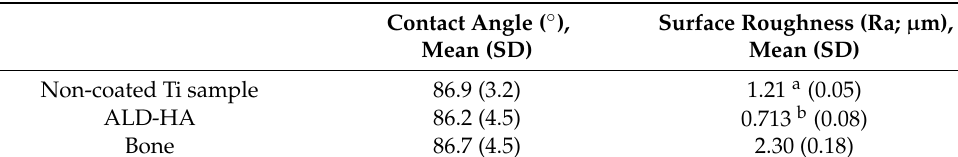
Table 1. Mean and standard deviation of water contact angle and surface roughness determination on non-coated Ti sample, ALD-HA, and bovine bone slice. a p < 0.001, non-coated Ti sample vs. ALD-HA or bone; b p < 0.001, ALD-HA vs. bone.